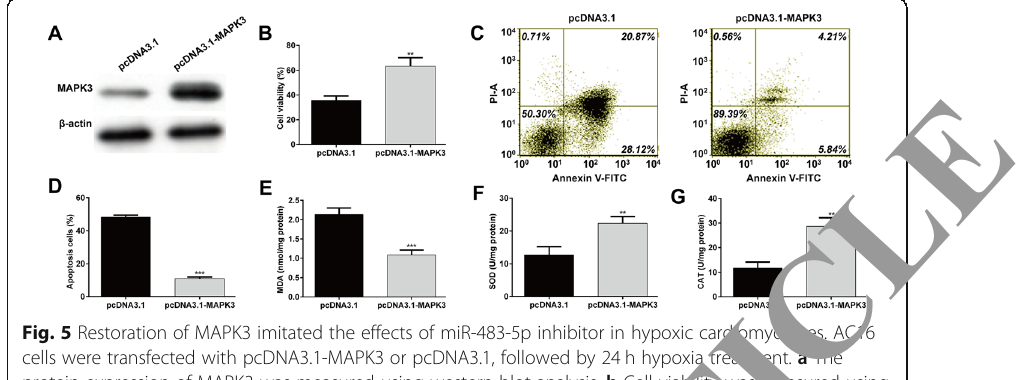
Fig. 5 Restoration of MAPK3 imitated the effects of miR-483-5p inhibitor in hypoxic cardiomyocytes. AC16 cells were transfected with pcDNA3.1-MAPK3 or pcDNA3.1, followed by 24 h hypoxia treatment. a The protein expression of MAPK3 was measured using western blot analysis. b Cell viability was measured using a CCK-8 assay. c and d Cell apoptosis was analyzed using flow cytometry with double Annexin V FITC-PI staining. e through g The content of MDA, the activities SOD and CAT (G) were measured using commercial assay kits. Data are indicated as means ± SD of three independent experiments. ** p < 0.01, *** p < 0.001, as compared with